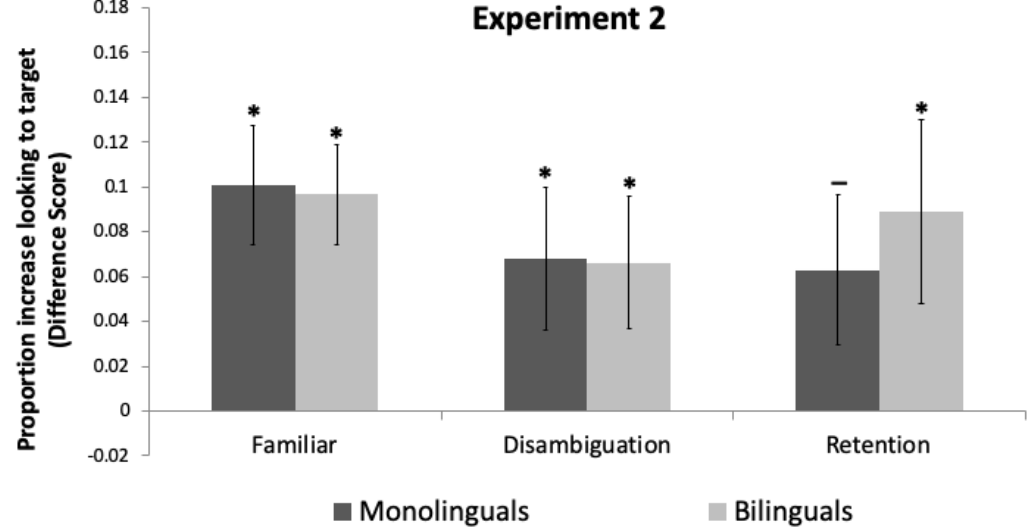
Figure 3. Difference scores and standard errors for Experiment 2. Trial type is on the X -axis. The Y -axis gives the proportion of looking to the target object post-naming–pre-naming periods. Positive scores indicate increased looking to the target object. * indicates a p -value smaller than 0.05, —indicates a marginal but non-significant p -value.